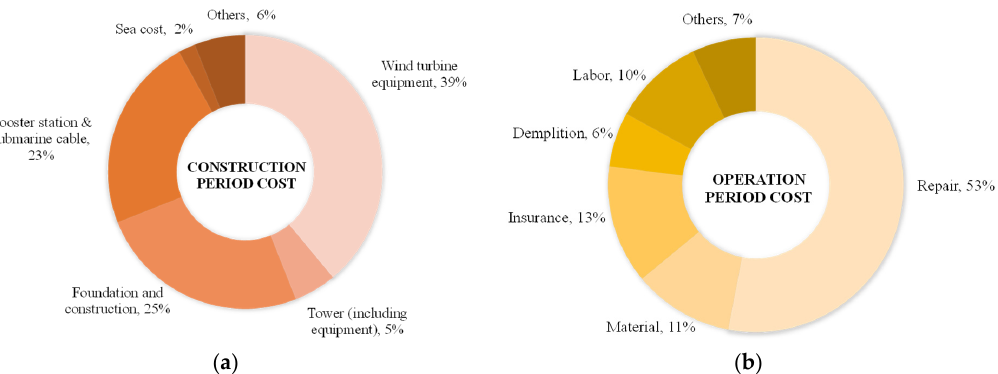
Figure 1. The total installed capacity of OWP over the years.